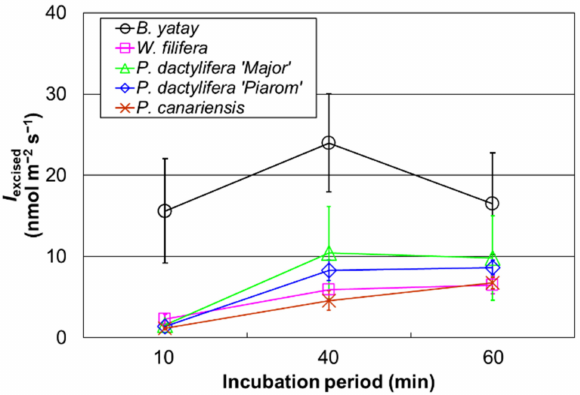
Figure 4. The isoprene emission rate obtained using excised leaves ( I excised ) for incubation periods of 10, 40, and 60 min. Open circles, squares, triangles, diamonds, and crosses represent the mean I excised values of B. yatay ( n = 5), W. filifera ( n = 4), P. dactylifera ‘Major’ ( n = 4), P. dactylifera ‘Piarom’ ( n = 4), and P. canariensis , respectively. Vertical bars represent the standard